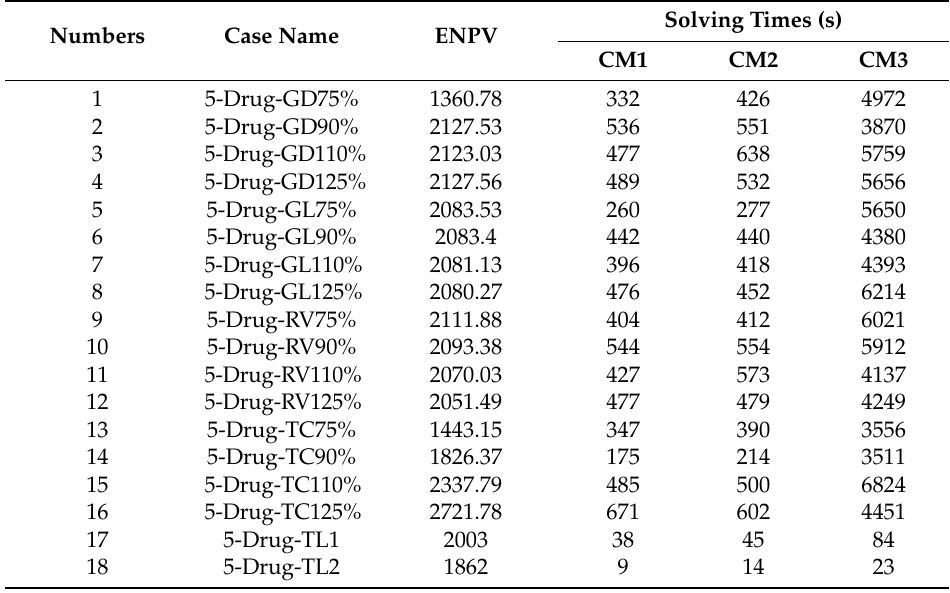
Table A6. Parameter perturbation results for CM1, CM2 and